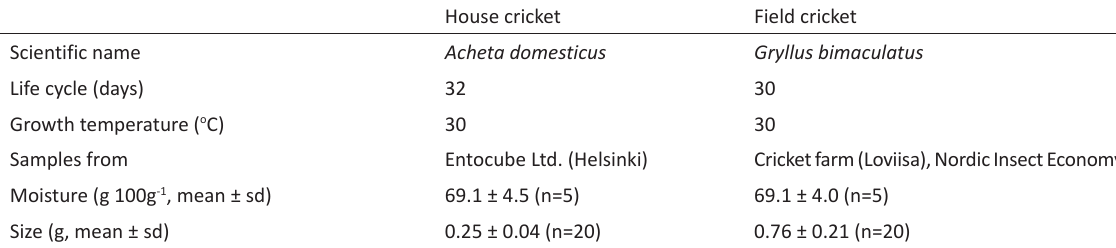
Table 1. Background information of the